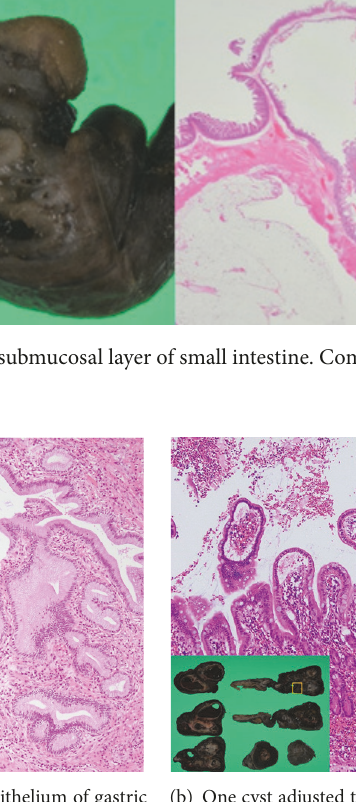
(a) One of the cysts showed the epithelium of gastric pyloric gland